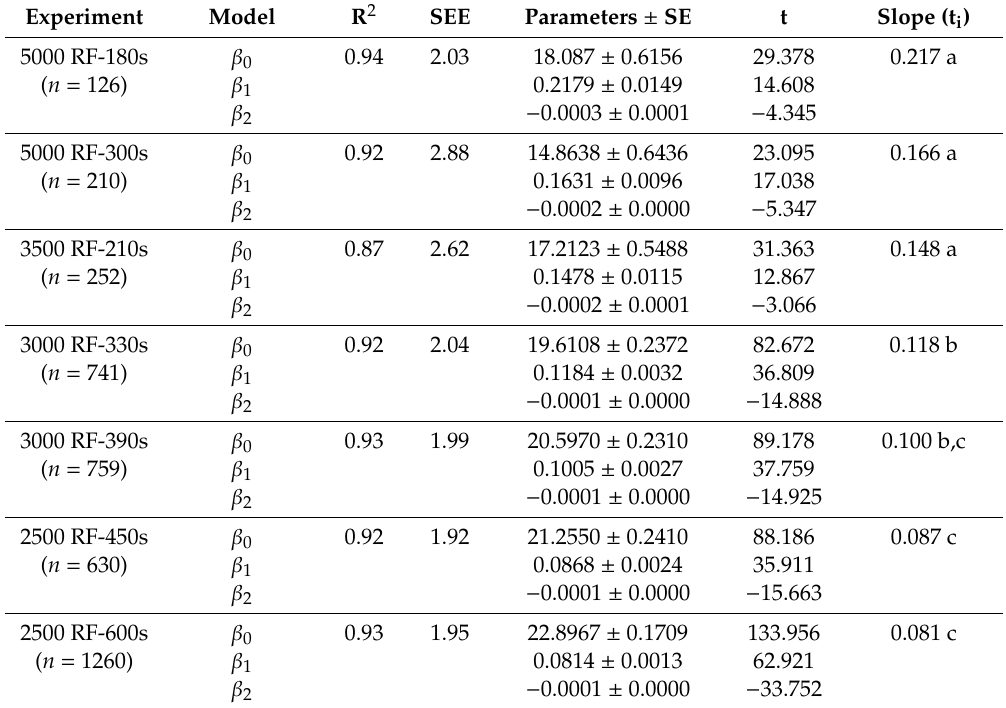
Table 2. Estimates of the polynomial regressions parameters of the relationship between temperature ( ◦ C) and RF application time (s) in di ff erent RF experiments.